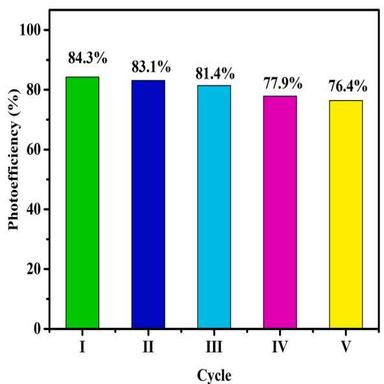
Photoefficiency Trends of the Fe-GO Nanocomposite across Successive Catalytic Cycles.